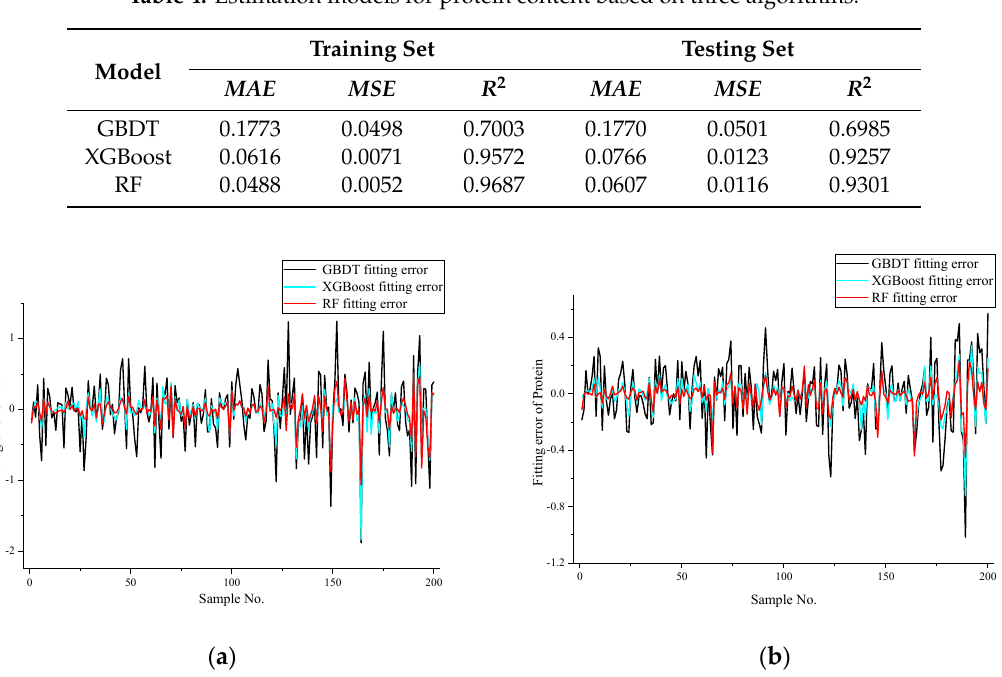
Figure 5. Model estimation error: ( a ) model errors for fat; ( b ) model errors for protein.